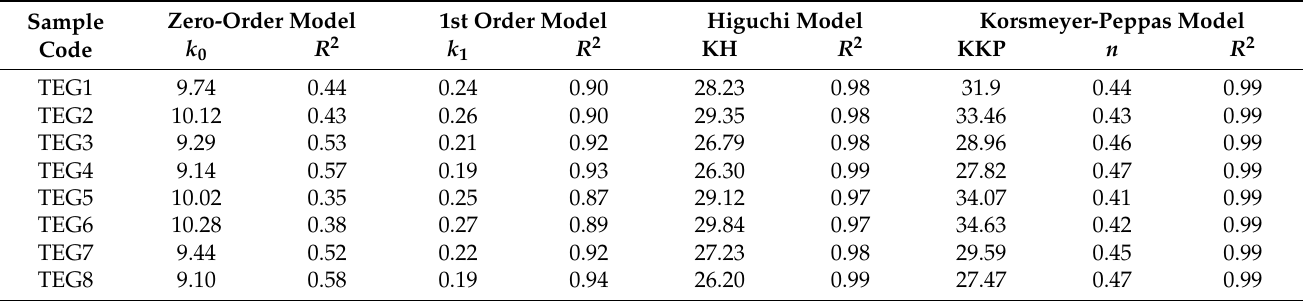
Table 4. Drug release kinetics of